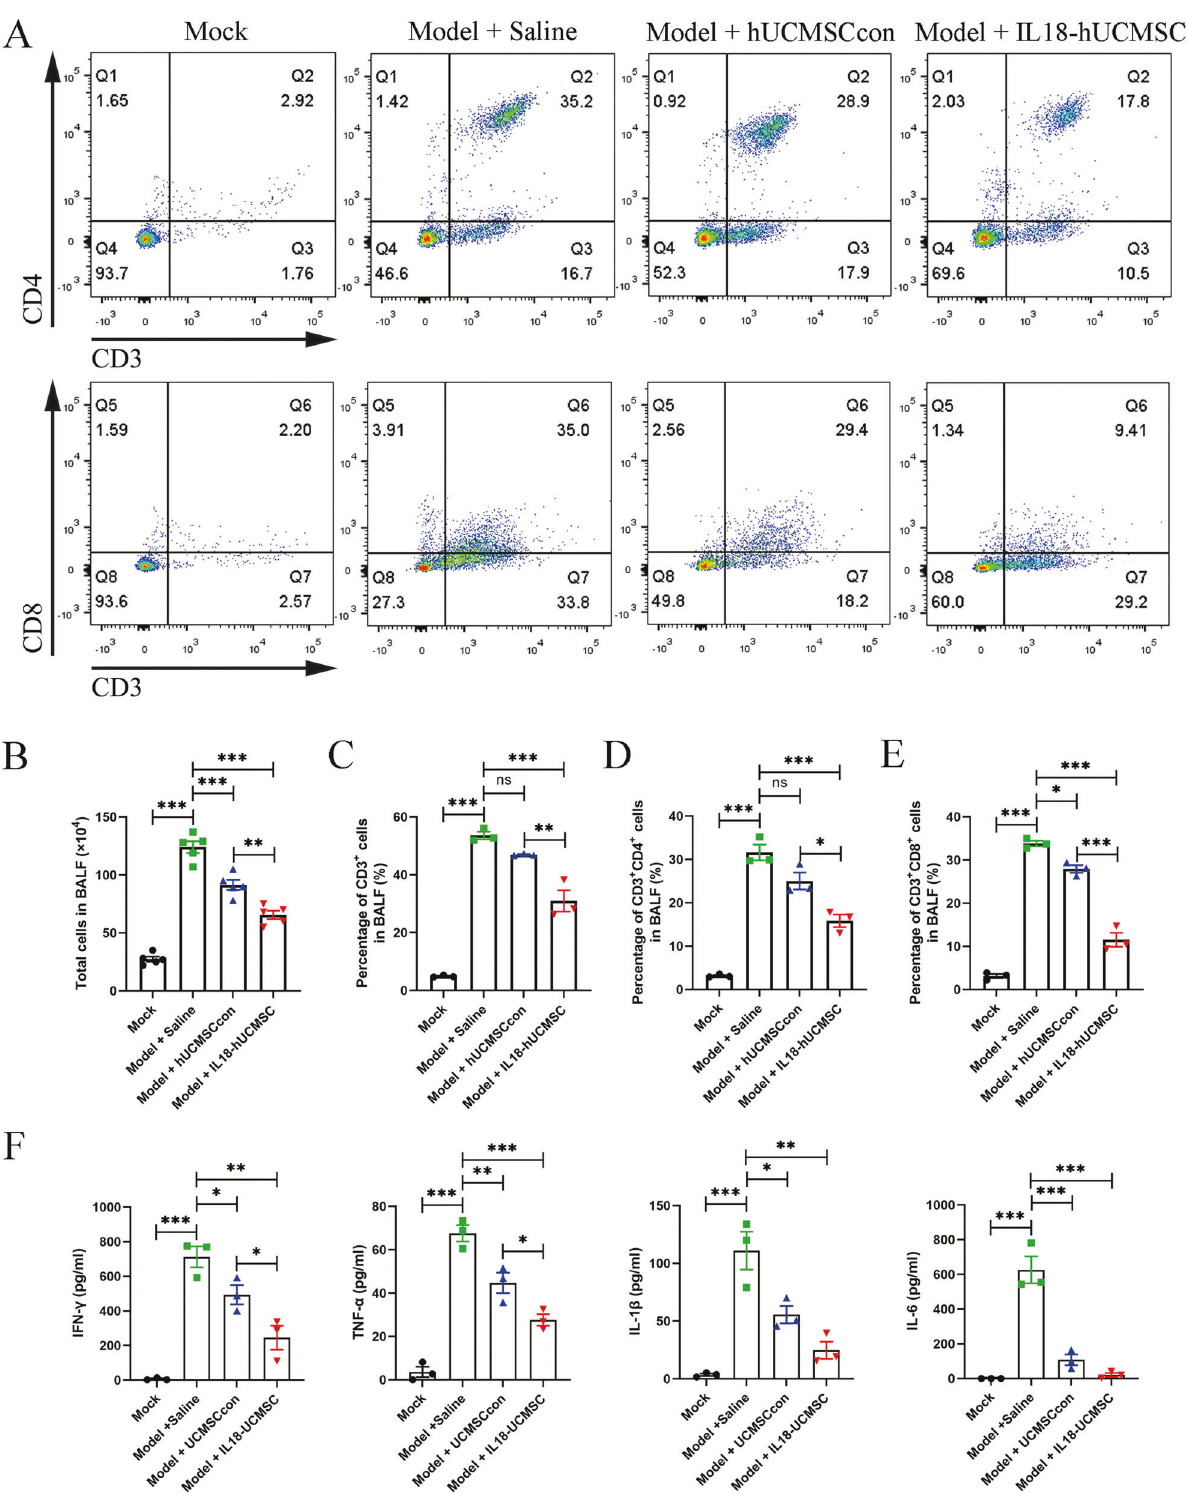
Fig. 5 IL18-hUCMSC has a superior immunosuppressive effect on T-cells and the secretion of proin fl ammatory cytokines in BALF. A The CD3 + T-cell and its CD4 + and CD8 + subpopulations in BALF at 7 dpi were analyzed by fl ow cytometry. B – E The number of total cells in BALF was counted ( B ), and the percentage of CD3 + T-cell ( C ), CD4 + T-cell ( D ) and CD8 + T-cell ( E ) in BALF were calculated according to fl ow cytometric analysis. F The protein level of pro-in fl ammatory cytokines (IFN- γ , TNF- α , IL-1 β , and IL-6) in BALF at 7 dpi was analyzed by ELISA kit. Data are shown as mean ± SEM. n = 3-5 in each group. * p < 0.05, ** p < 0.01, *** p < 0.001, ns = not signi fi cant.